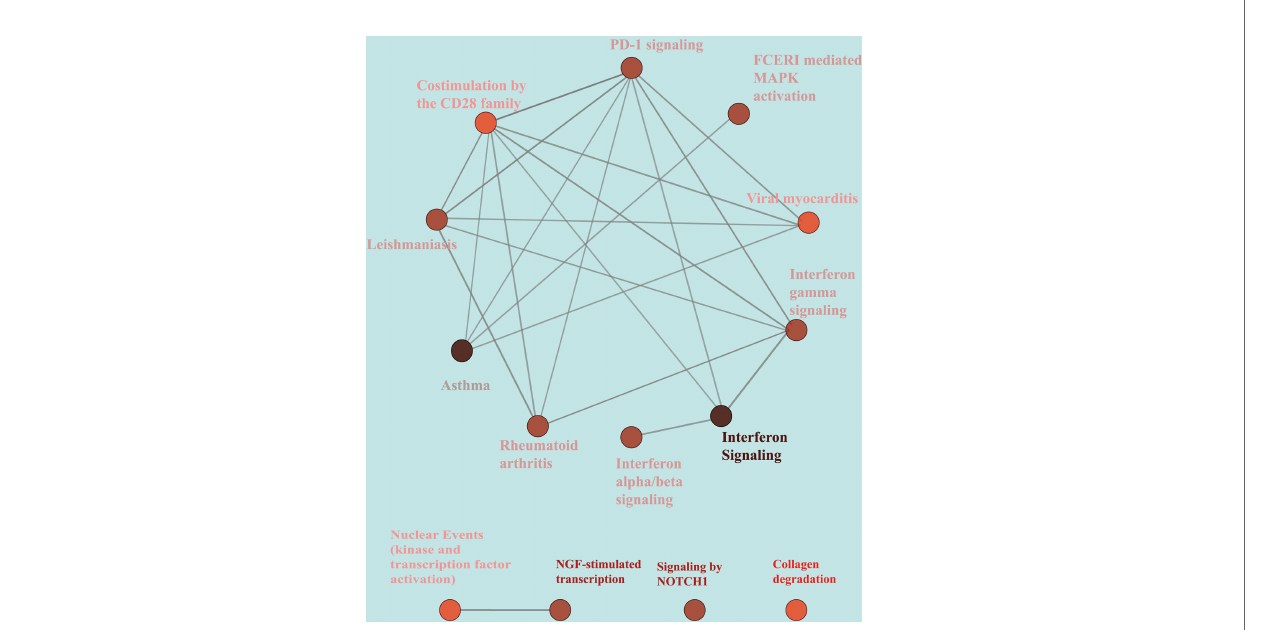
FIGURE 3 | KEGG/Rectome pathways enrichment analysis of Robust DEGs. KEGG, Kyoto Encyclopedia of Genes and Genomes. Rectome, Rectome pathway database.